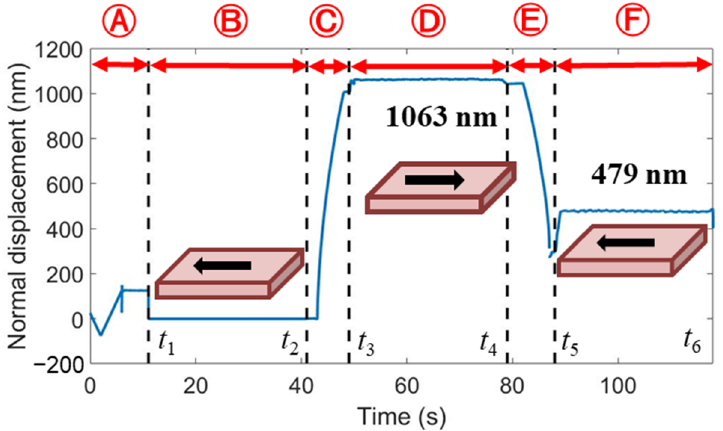
Figure 6. The evolution of the corrected normal displacement with time for scratching with an edge-forward Berkovich indenter, under the normal load of 200 mN.